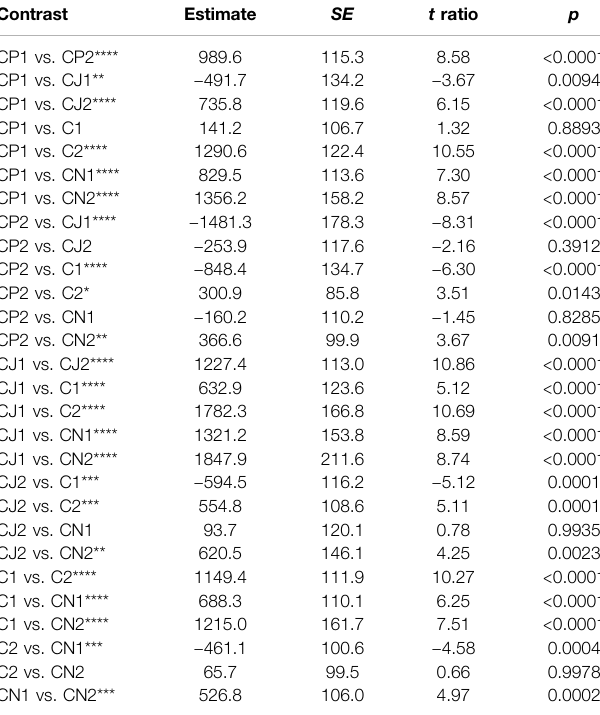
TABLE 12 | Results of the linear mixed effects model for the response times of correct answers of Chinese word and picture pairs (CP), Chinese word and Japanese word pairs (CJ), Chinese words only (C), and novel Chinese words (CN) in learning condition retrieval tasks.